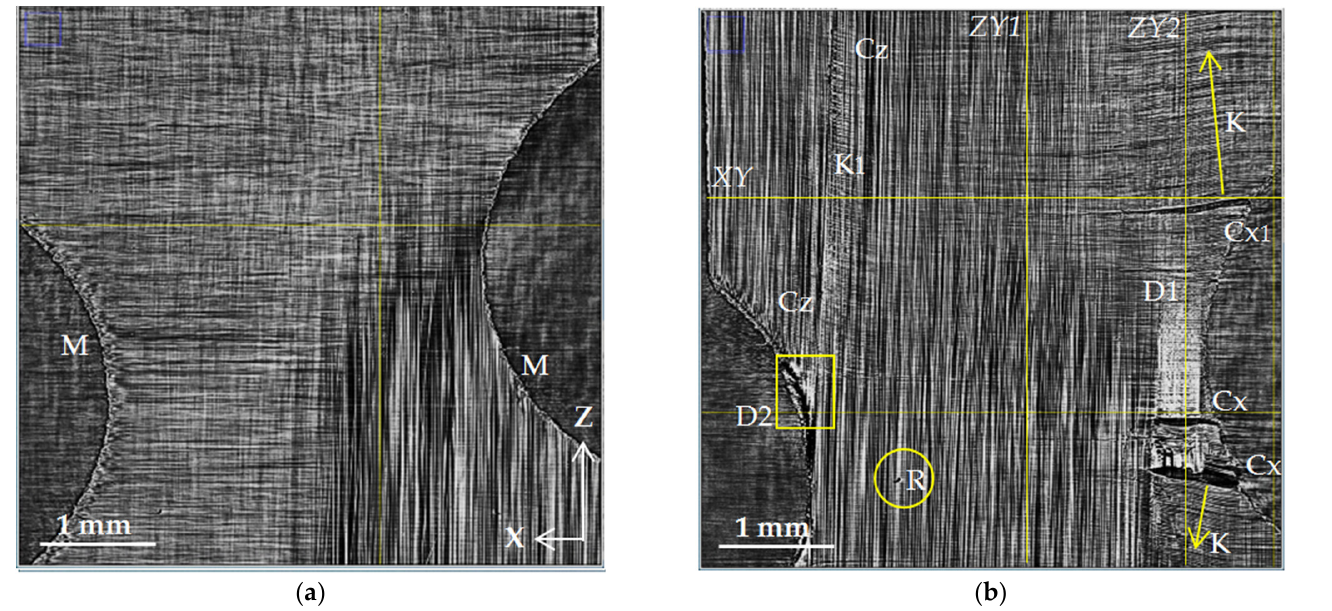
Figure 6. Microstructure of cross-ply CFR plastic at the interface of adjacent [90/0] layers: ( a ) initial state, 38 MPa; ( b ) loaded state, 865 MPa; M—mechanical damage after cutting; Cx—transverse crack spreading along the X-axis; K, K 1 —kinking of fibers; D—interlayer delamination; R—fiber rupture; XY, YZ1, and YZ2—positions of the orthogonal X-ray sections presented in Figures 8 and 9.